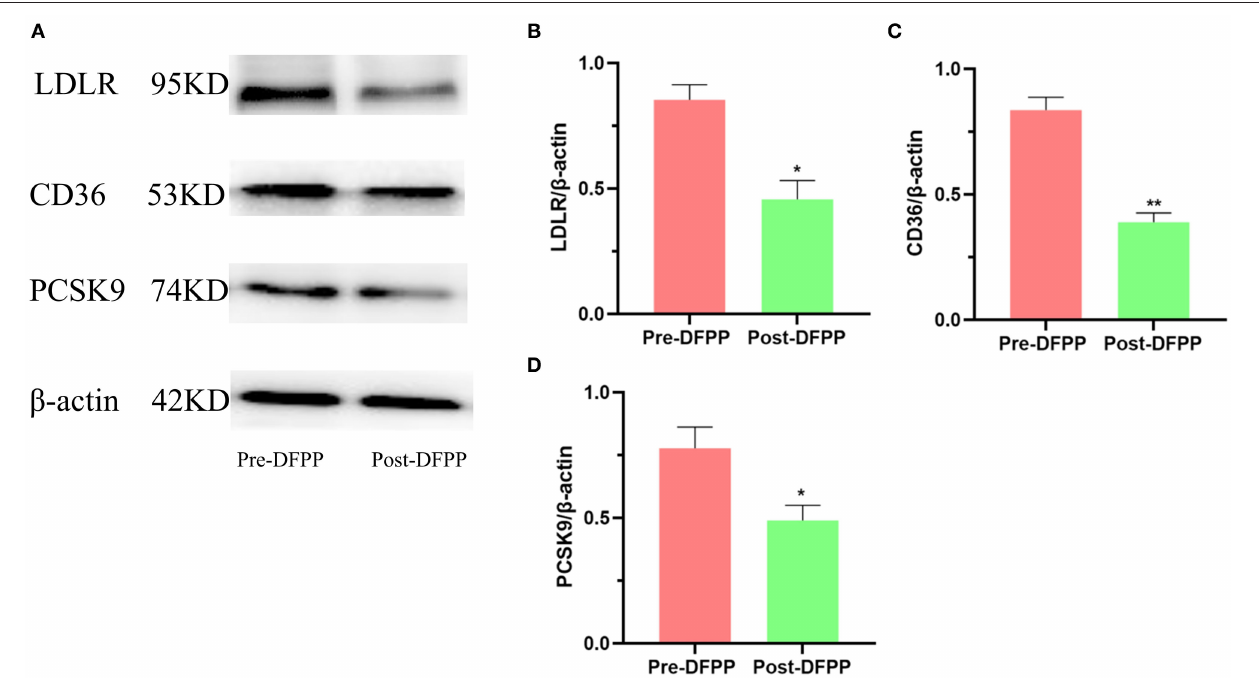
FIGURE 1 | Effects of DFPP on expressions of lipid metabolic proteins. PBMCs protein samples are extracted from patients with high cholesterol and/or high LDL-C. (A) Westernblot result picture of lipid metabolic proteins. Western blot analyses detected the protein expression of LDLR (B) , CD36 (C) , and PCSK9 (D) in PBMCs. Pre-DFPP: patients before DFPP. Post-DFPP, patients after DFPP. Values were expressed as mean ± SD. * P < 0.05 and ** P < 0.01 vs. pre-DFPP. N =